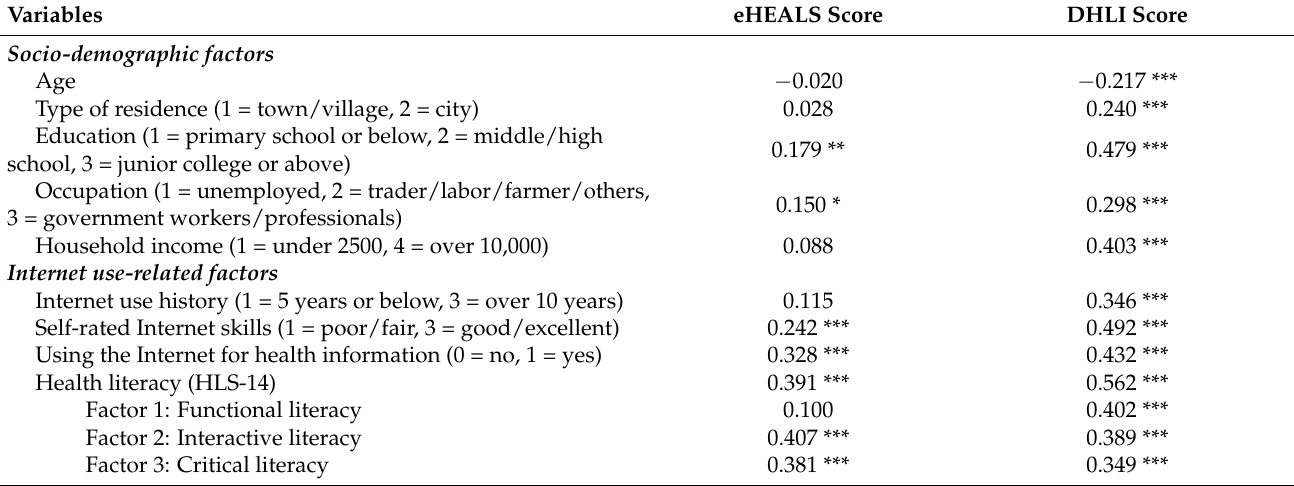
Table 2. Correlations between two eHealth literacy scales and construct variables (N =